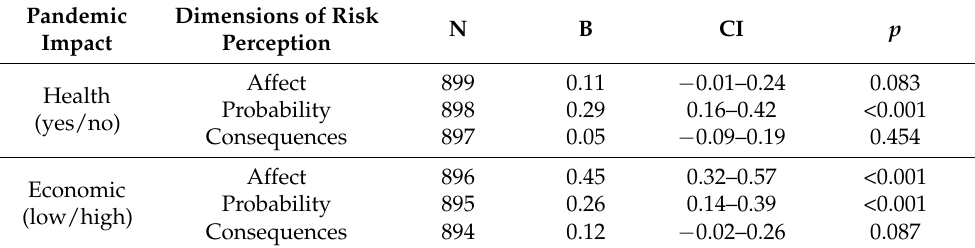
Table 3. Results of the six individual linear regression models regarding the association of pandemic- related health or economic impact and SARS-CoV-2 risk perception